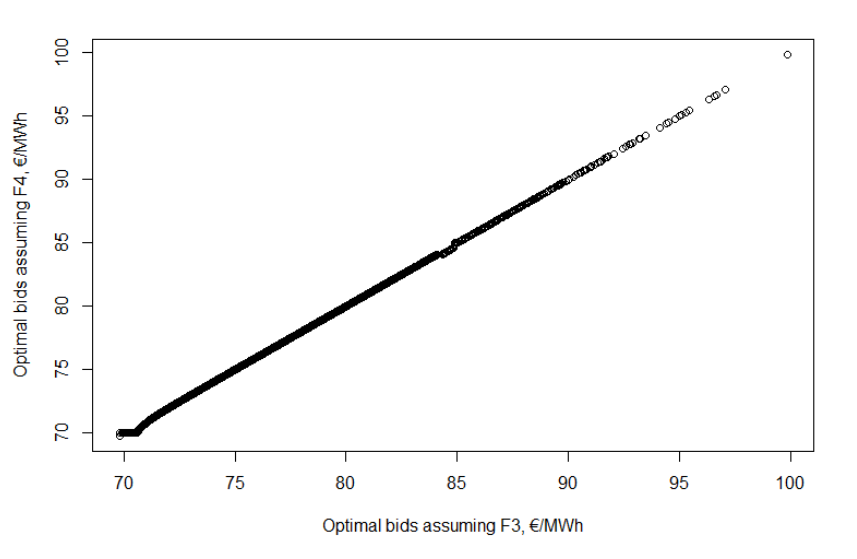
Figure 10. Optimal bids for given valuations assuming F 3 and F 4 bid distribution, source: own